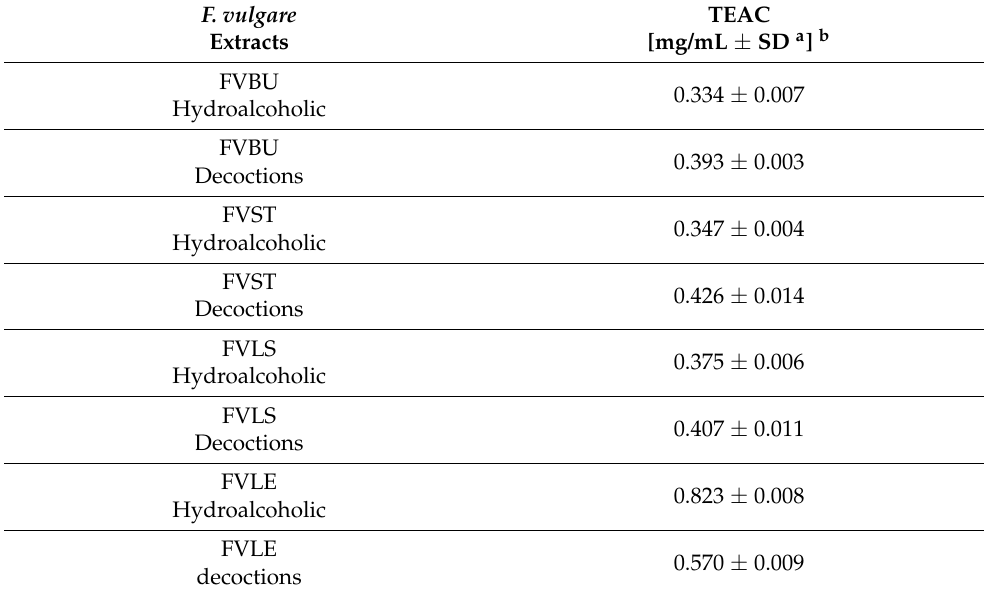
Table 3. Antioxidant activity of extracts of F. vulgare evaluated by Trolox Equivalent Antioxidant Capacity (TEAC).